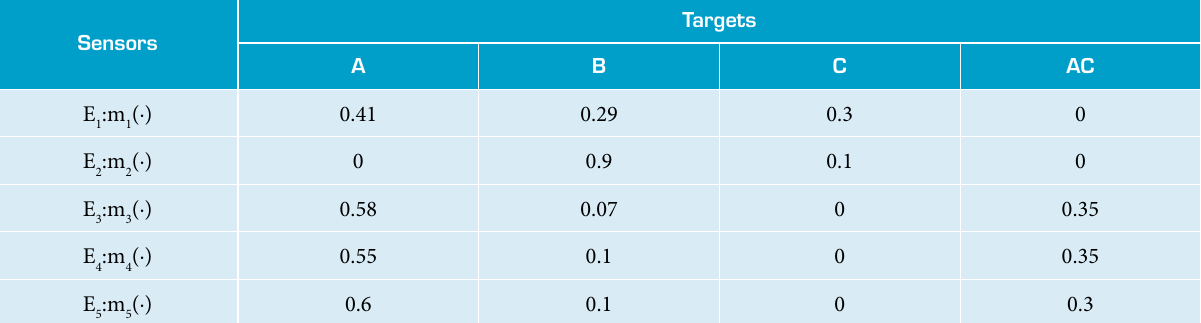
Table 5. Mass assignments of multi-elements subsets.